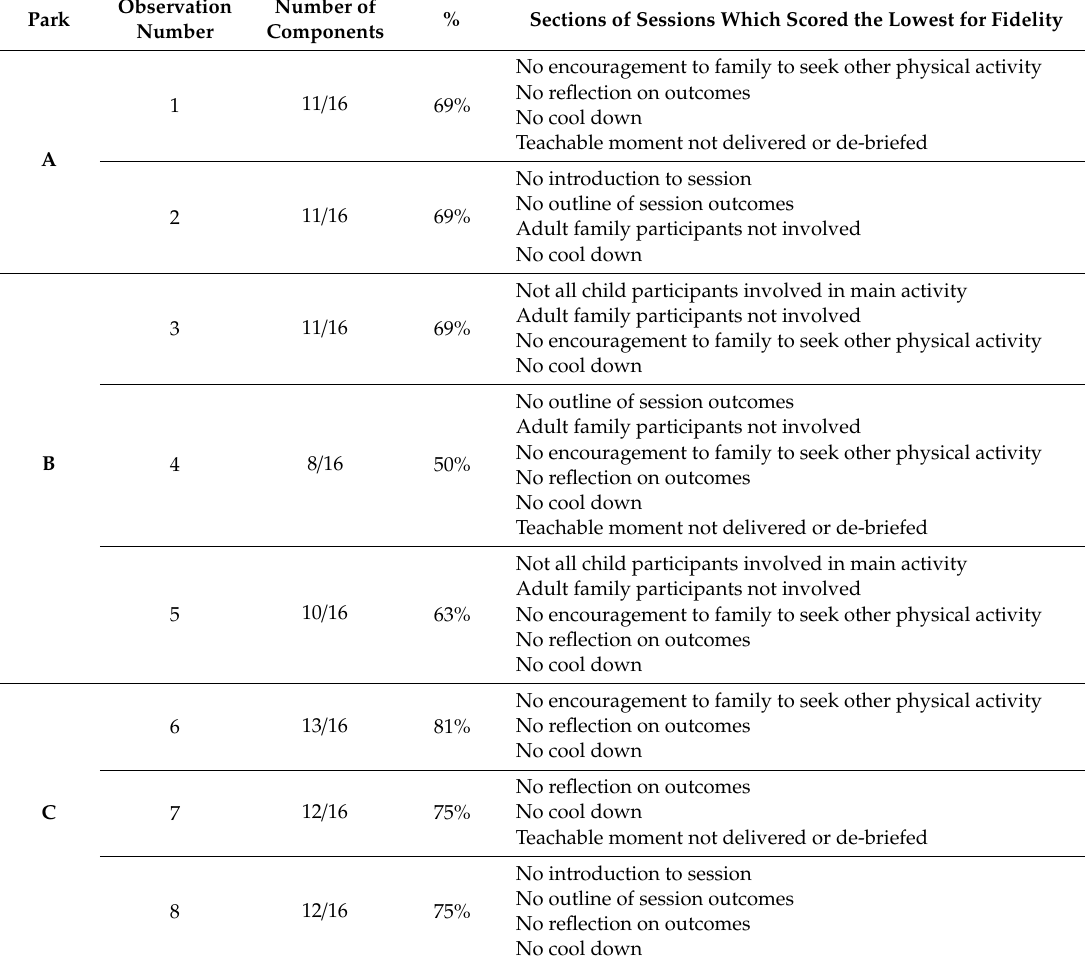
Table A1. Fidelity scores for coach session